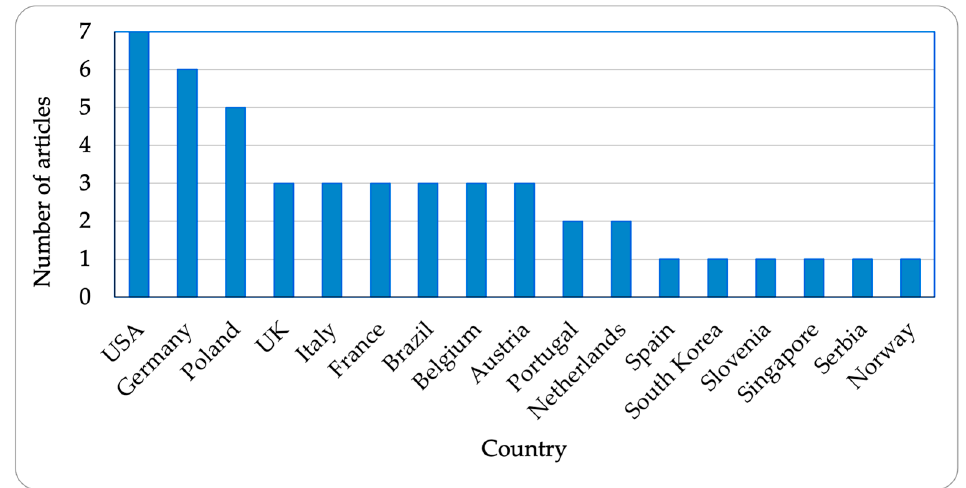
Figure 2. Geographical distribution of studies dedicated to CB issues.